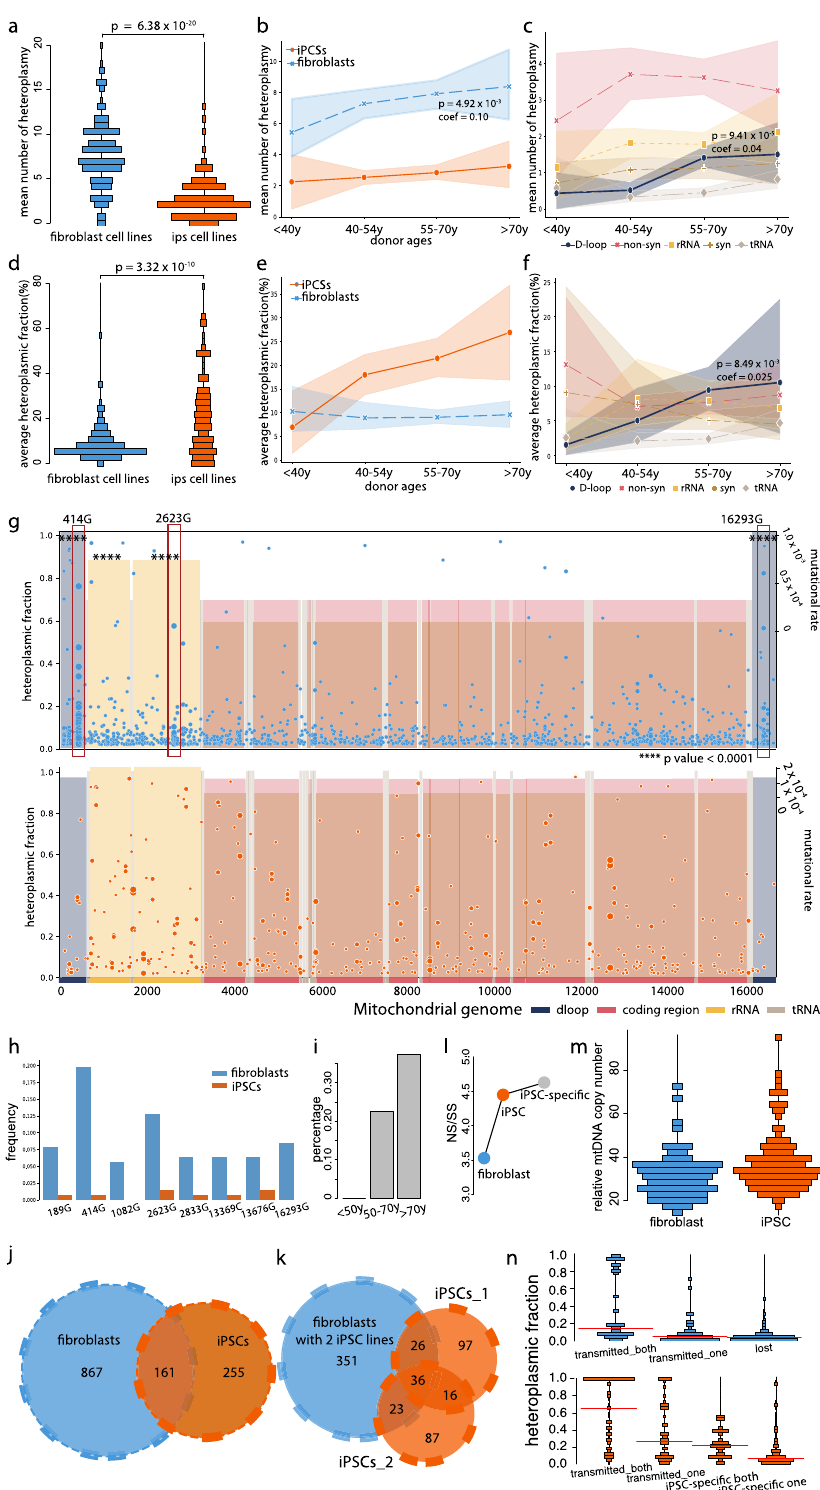
Cell reprogramming changes the spectrum of mtDNA muta- tions . Next, we carried out a similar analysis of high-depth mtDNA sequences in 141 iPSCs derived from 83 of the original fi broblast lines (Fig. 1a, Supplementary Fig. 1a and Supplemen- heteroplasmy (HF > = 2%). The mean number of